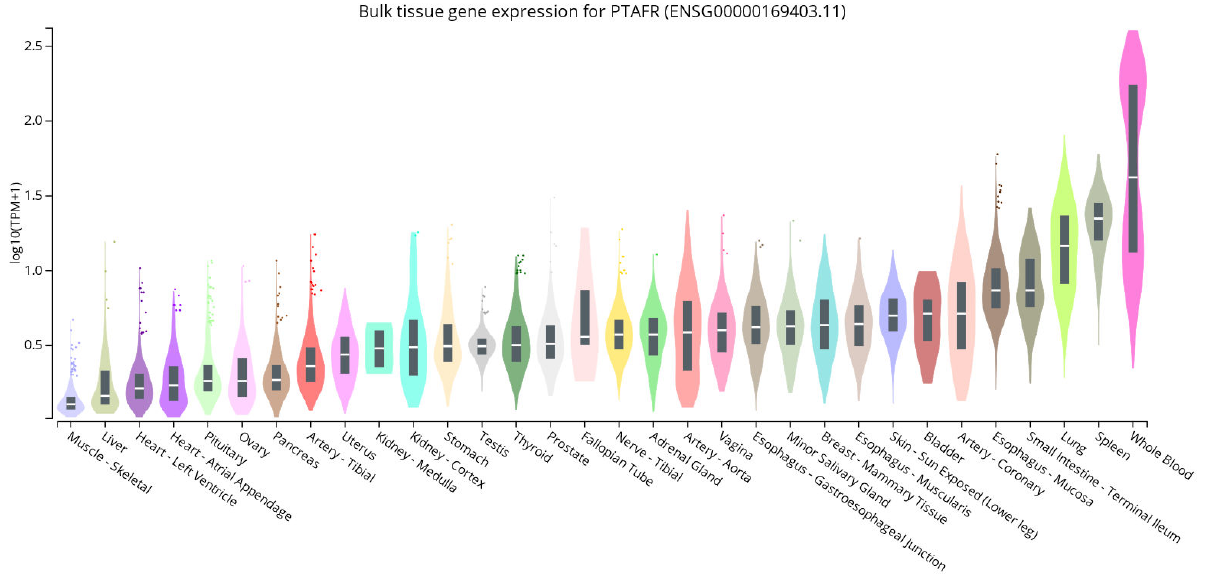
Figure 1. Bulk gene expression for the platelet-activating factor receptor (PAF-R) encoded by the gene PTAFR in various human tissues using data from the Genotype-Tissue Expression (GTEx) Project [30]. The expression data is shown in transcripts per million (TPM) with the plots showing the median and the 25th and 75th percentiles. Dots indicate outliers, which are above or below 1.5 times the interquartile